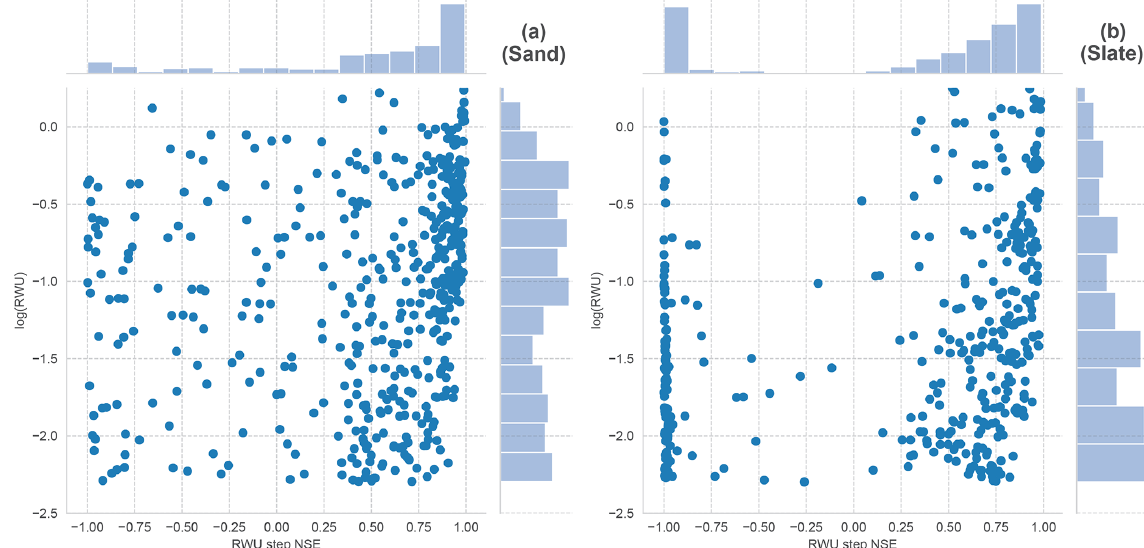
Figure B1. Identified RWU (log10 of RWU in mmd − 1 on y axes) and corresponding step coherence as NSE to synthetic step ( x axes) for the sand site (a) and slate site (b) . Marginals give the respective